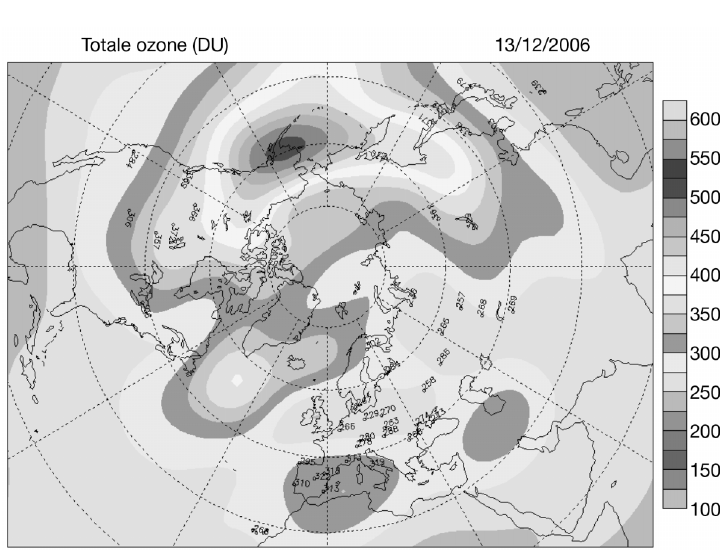
Fig. 4. Ozone total column contour map in Dobson Units from the World Ozone and Ultraviolet Radiation Da- ta Centre (WOUDC) in Toronto (<http://es-ee.tor.ec.gc.ca>) for 13 December,